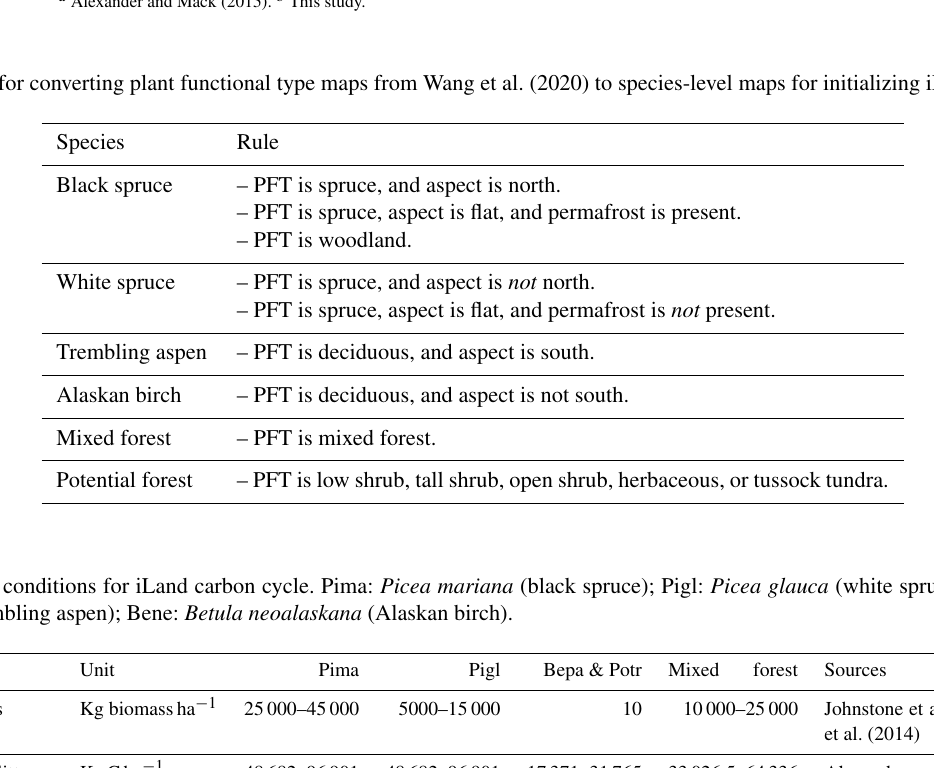
Table B2. Carbon cycle parameters of iLand. Pima: Picea mariana (black spruce); Pigl: Picea glauca (white spruce); Potr: Populus tremu- loides (trembling aspen); Bene: Betula neoalaskana (Alaskan birch). Parameter Pima Pigl Bepa Potr Litter C : N ratio a 73 73 17.9 21 Fine root C : N ratio a 45 45 45 45 Wood C : N ratio a 425.6 425.6 336.6 405.5 Standing snag decomposition under optimal climate b 0.2 0.2 0.2 0.2 Snag half-life b 25 15 15 15 Litter decomposition under optimal climate b 0.23 0.33 0.39 0.56 0.06 0.02 0.15 0.15